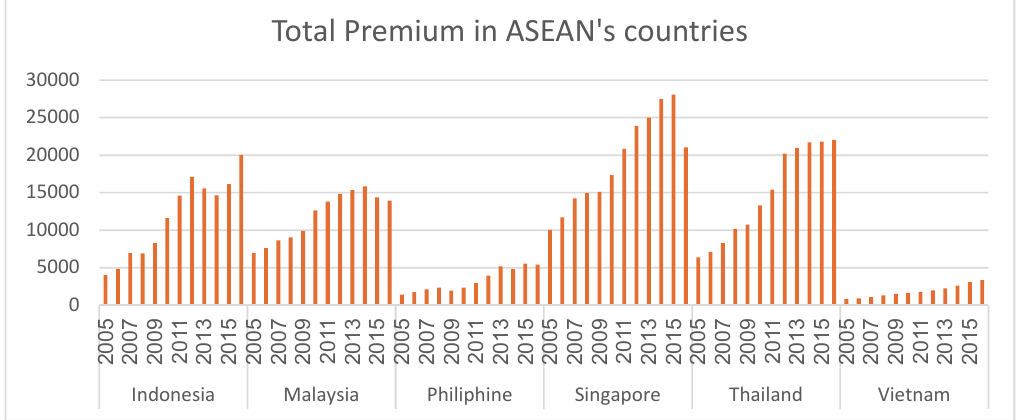
Fig. 2. Total Premium of ASEAN’S Countries